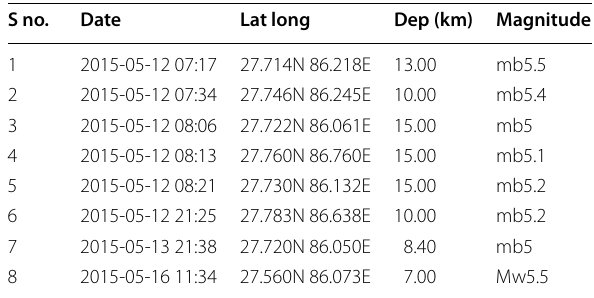
Table 2 Earthquakes considered for the HVSR method for four temporary